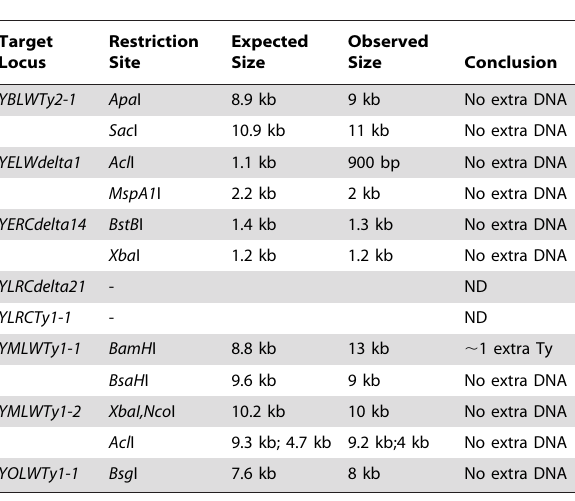
Table 5. Analysis of centromere-oriented Ty target loci.